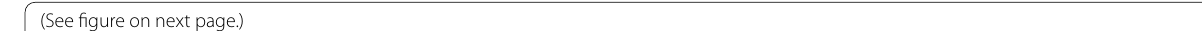
(See figure on next page.) Fig. 4 RMSD and RMSF analyses at different temperatures and NaCl concentrations. A RMSD of An EGL at 300 K within 50 ns MD simulation. B RMSD of An EGL at 350 K within 50 ns MD simulation. C RMSF of C‑α at 300 K within 20 to 50 ns MD simulation. D RMSD of C‑α at 350 K within 20 to 50 ns MD simulation. E Activity analysis on An EGL at 300 K within 20 to 50 ns MD simulation. F Activity analysis on An EGL at 350 K within 20 to 50 ns MD simulation. The proteins are colored according to the RMSF of atom within 20 to 50 ns MD simulation. The activity from strong to weak is shown as colored gradient from red to